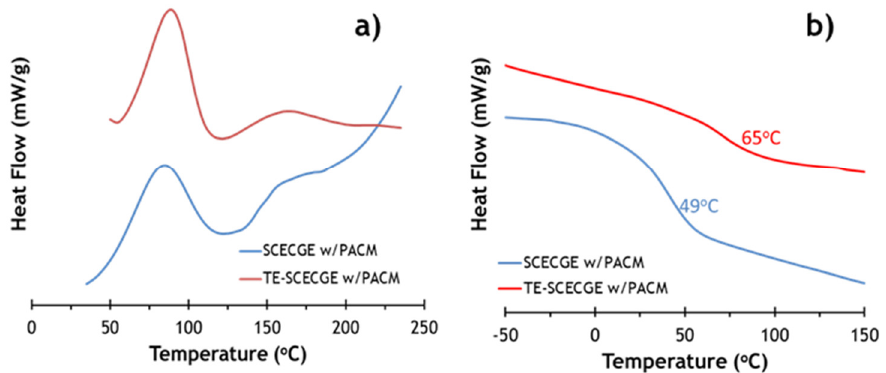
Table 2. Thermomechanical property comparison of SCECGE and TE-SCECGE.